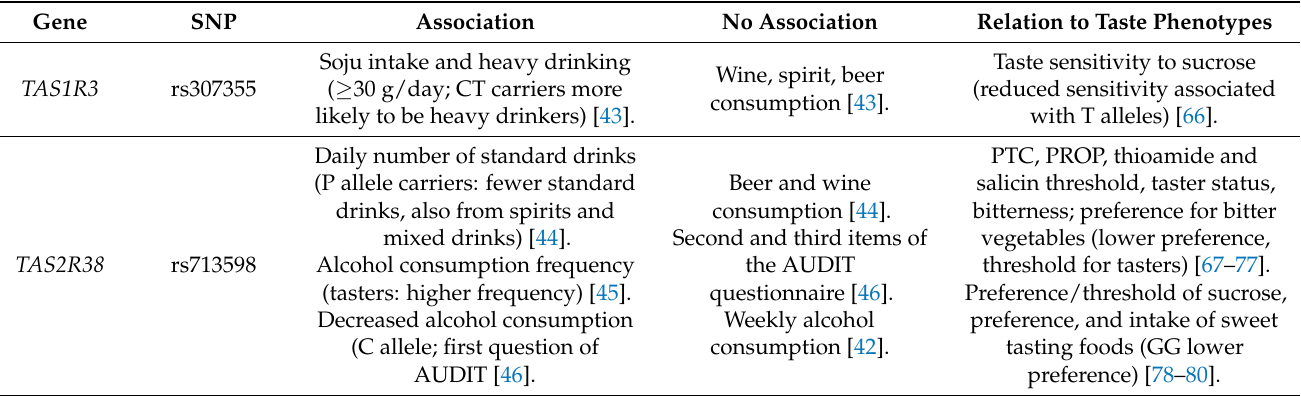
Table 1. Effect of selected genetic polymorphisms on alcohol consumption behavior and taste